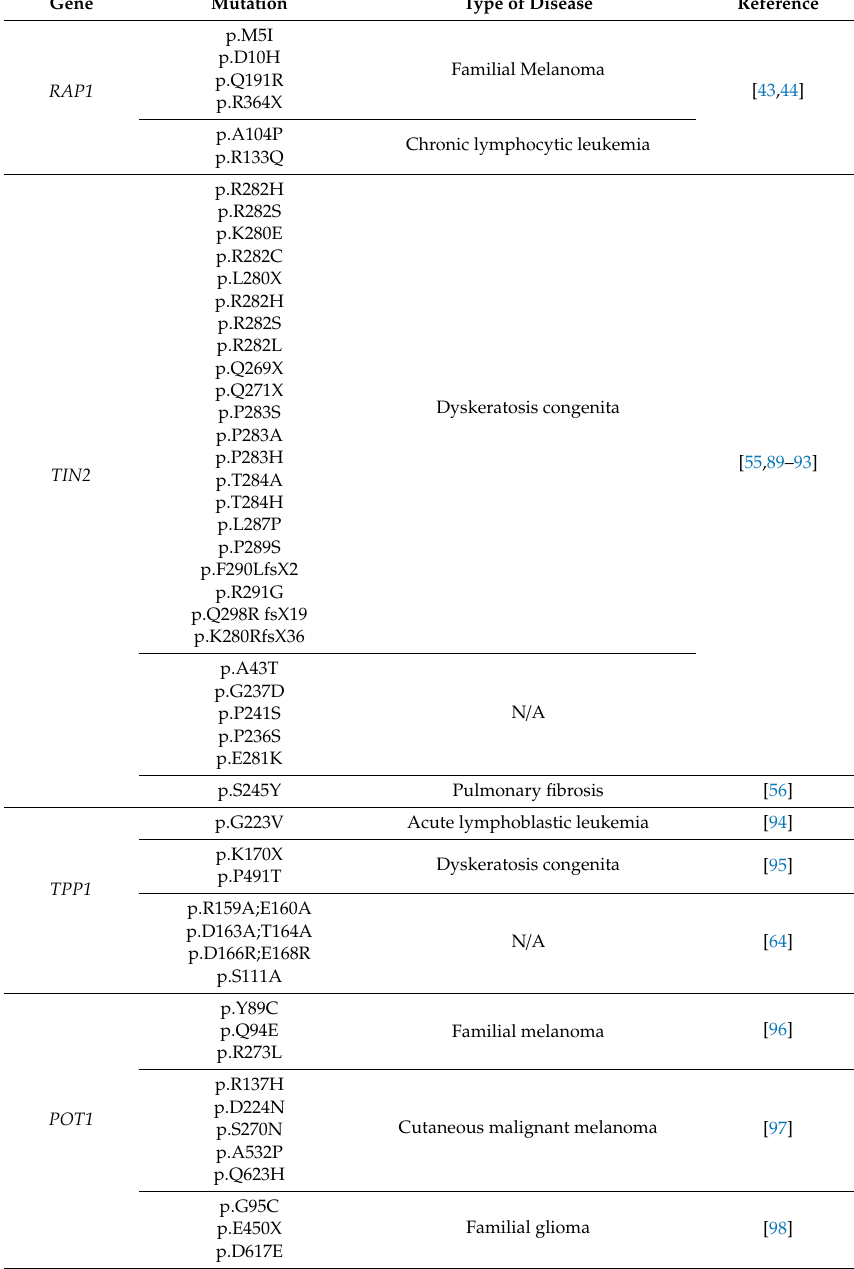
Table 1. Some clinically important mutations, associated genes, and their corresponding cellular pathologies. Among both complexes, protection of telomeres 1 (POT1) and conserved telomere maintenance component 1 (CTC1) appear as most recurrent mutated